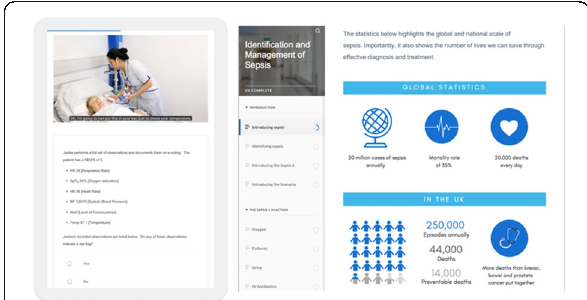
Fig. 1 (abstract P50). Screenshot of module on mobile device and desktop